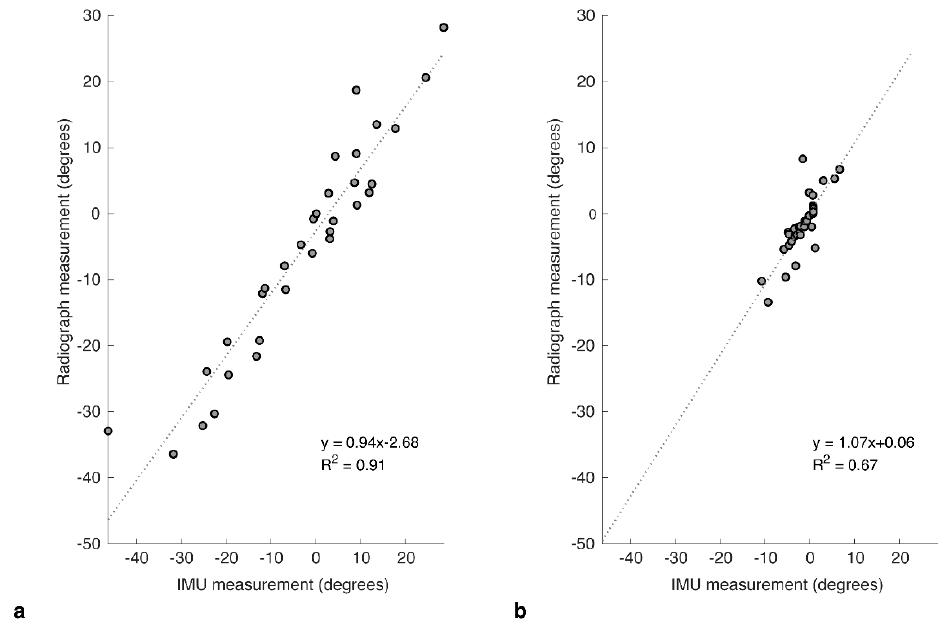
Figure 4. Correlation plots for IMU against the corresponding measures taken from radiograph images captured at the same time for relative change in pelvic tilt in ( a ) flexed-seated (FS) and ( b ) step-up (SU) positions, relative to standing.